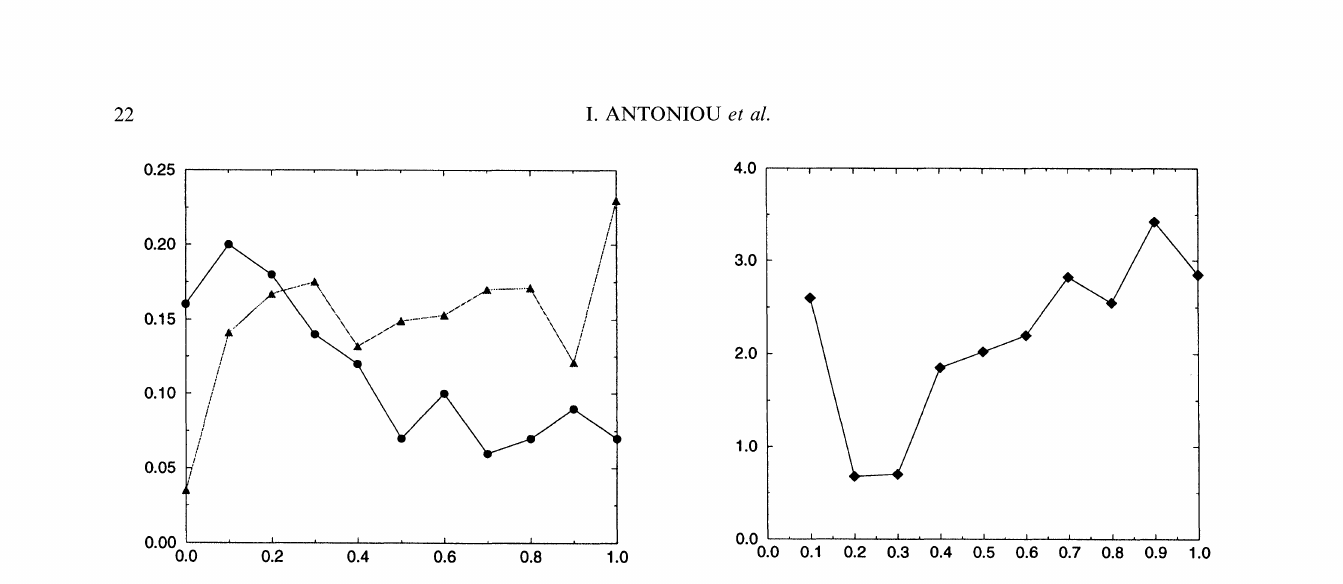
FIGURE 8 Amplitude of the main peak as a function of PL for vL=0.8 for the cases R1=200, R=50 (triangles) and R 50, R 200 (circles).